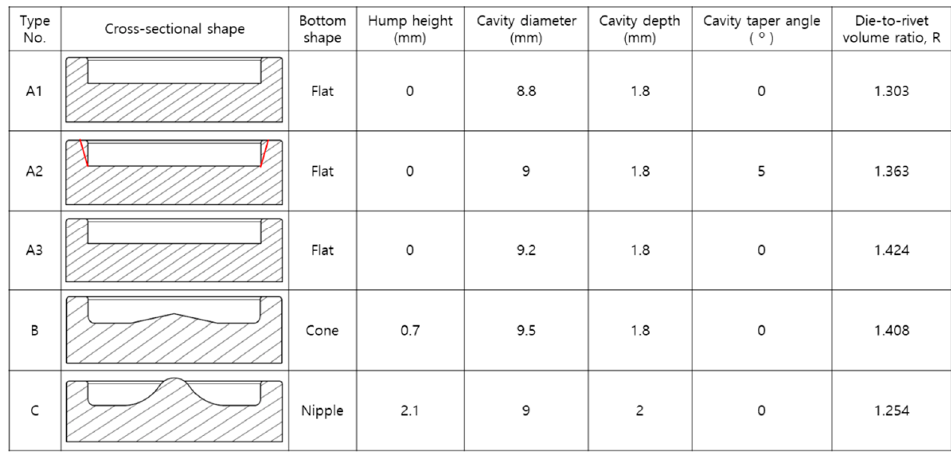
Figure 2. Engineering drawing of self-piercing rivet (SPR) rivet.